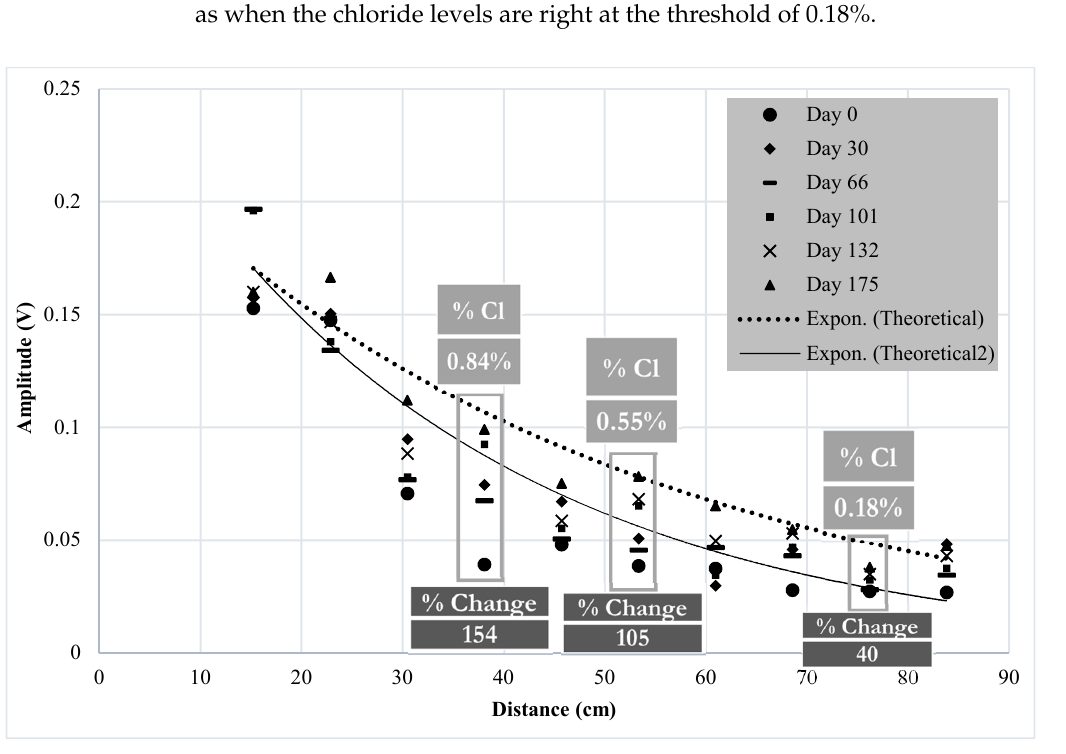
Figure 13. Correlation between UGWL data and chloride content.